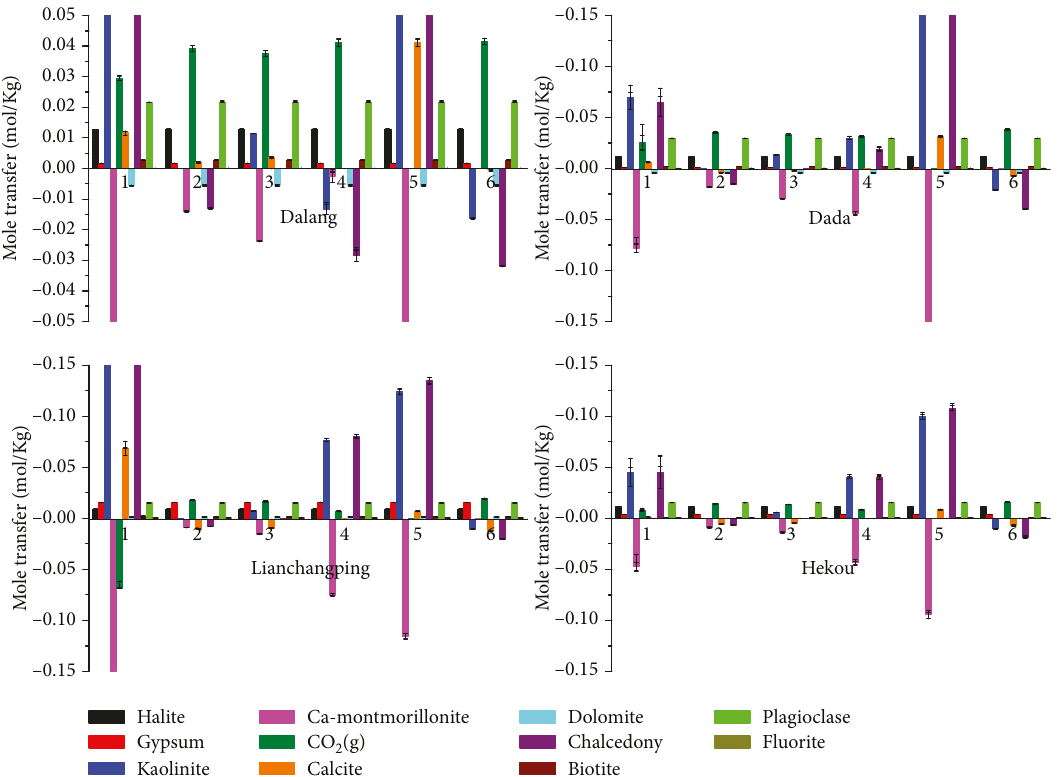
Figure 6: Mole transfer simulations. Dalang: simulation from local glacier melt water to the Dalang Spring; Dada: simulation from local glacier melt water to the Dada Spring; Lianchangping: simulation from local glacier melt water to the Lianchangping Spring; Hekou: simulation from local glacier melt water to the Hekou